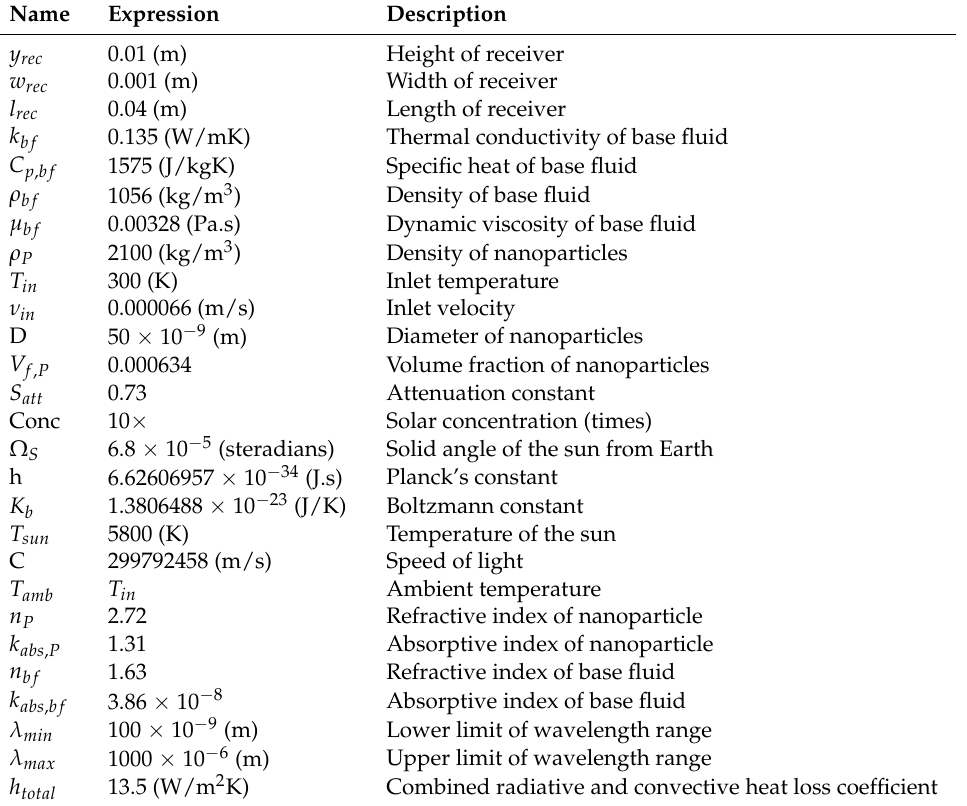
Table 1. Parameters used in the computational model.